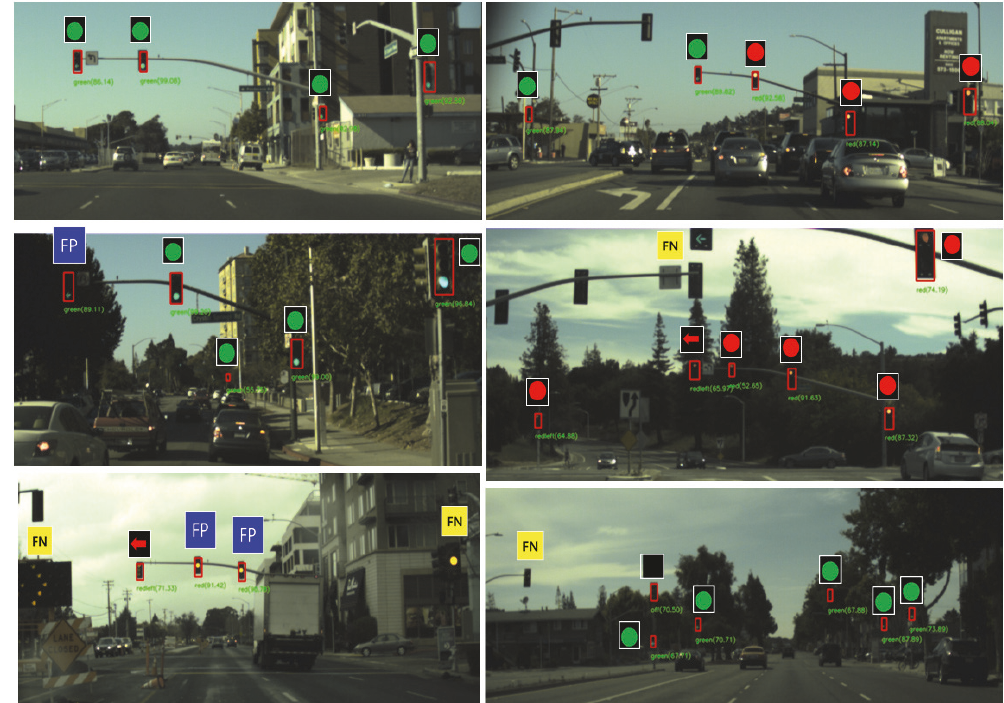
Figure 6: Traffic light detection examples of top-ranked RGB based Faster R-CNN model with Inception-Resnet-v2.